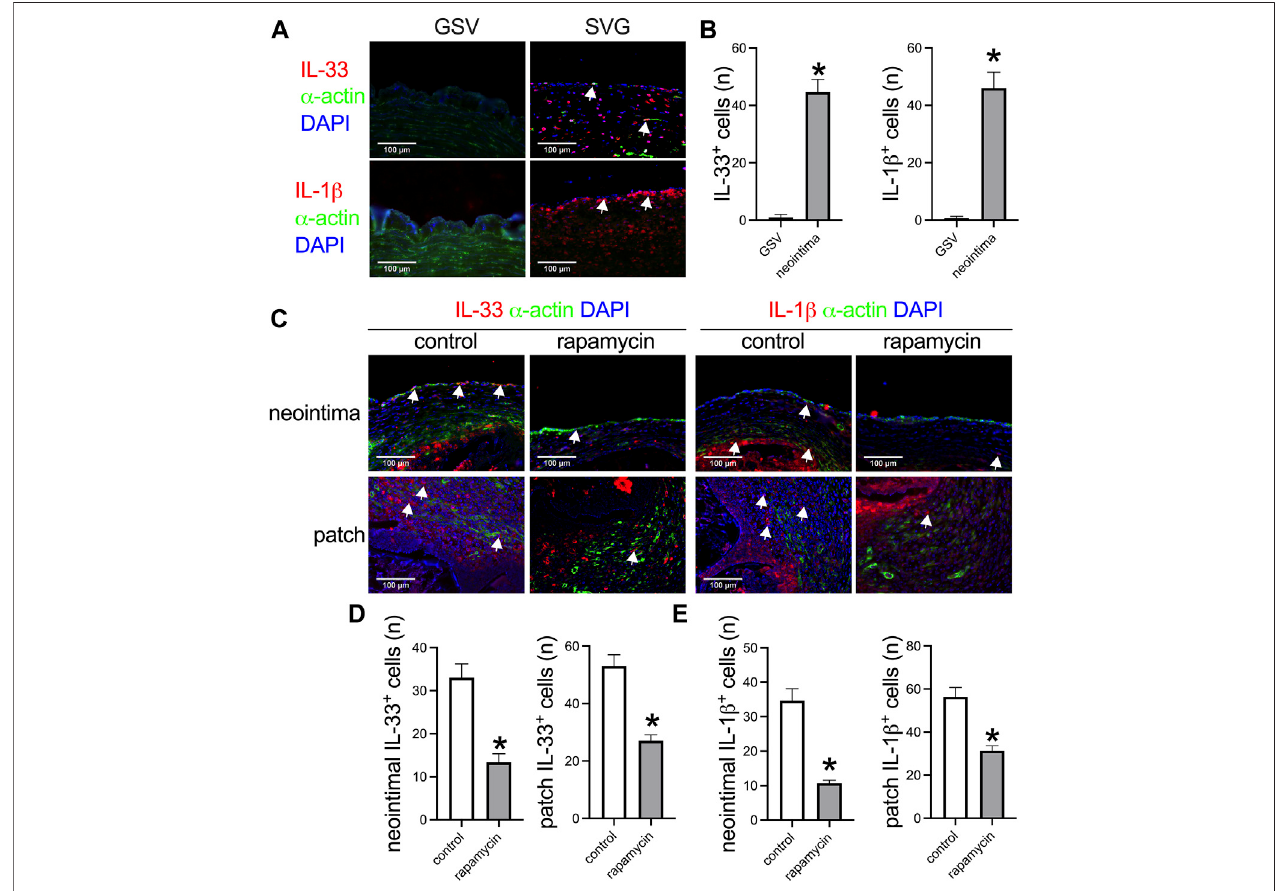
FIGURE4| HigherIL-33expressioncorrelatedwiththickervenousneointimalhyperplasiabothinhumansandrats. (A) Immuno fl uorescencestainedforIL-33(red), α -actin (green), and DAPI (blue); IL-1 β (red), α -actin (green), and DAPI (blue) in the human great saphenous vein (GSV) and spiral vein graft (SVG) neointima; white arrow showingthepositivecells; n (cid:2) 3. (B) BargraphsshowingtheIL-33positivecells(*, p (cid:2) 0.006,t-test)andIL-1 β positivecellsintheneointima(*, p (cid:2) 0.012,t-test); n (cid:2) 3. (C) Immuno fl uorescencestainedforIL-33(red), α -actin(green),andDAPI(blue);IL-1 β (red), α -actin(green),andDAPI(blue)inthecontrolandrapamycin-absorbedleaf neointima and patch; white arrow showing the positive cells; n (cid:2) 3. (D) Bar graphs showing the neointimal IL-33 positive cells (*, p (cid:2) 0.0066, t-test) and patch IL-33 positive cells (*, p (cid:2) 0.0046, t-test), n (cid:2) 3. (E) Bar graphs showing the neointimal IL-1 β positive cells (*, p (cid:2) 0.0026, t-test) and patch IL-1 β positive cells (*, p (cid:2) 0.0073, t-test), n (cid:2)